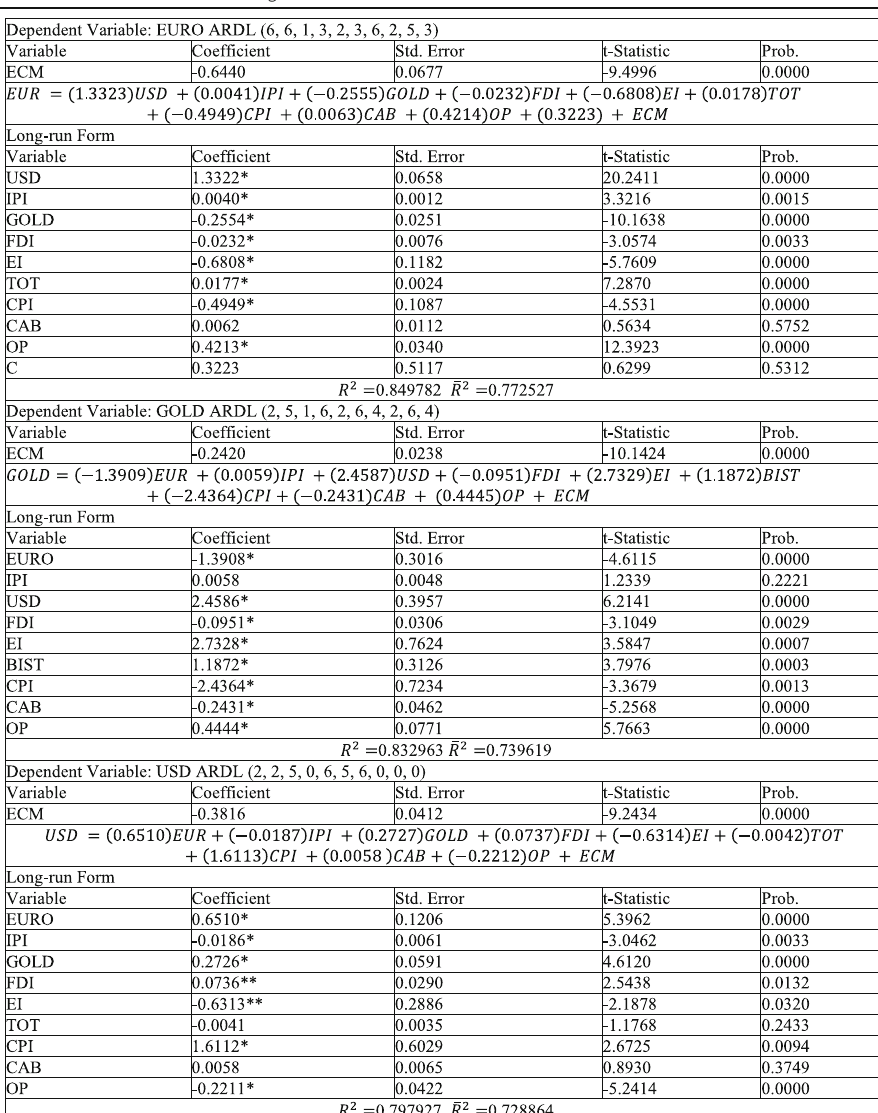
Table 4 ARDL model and long-term form